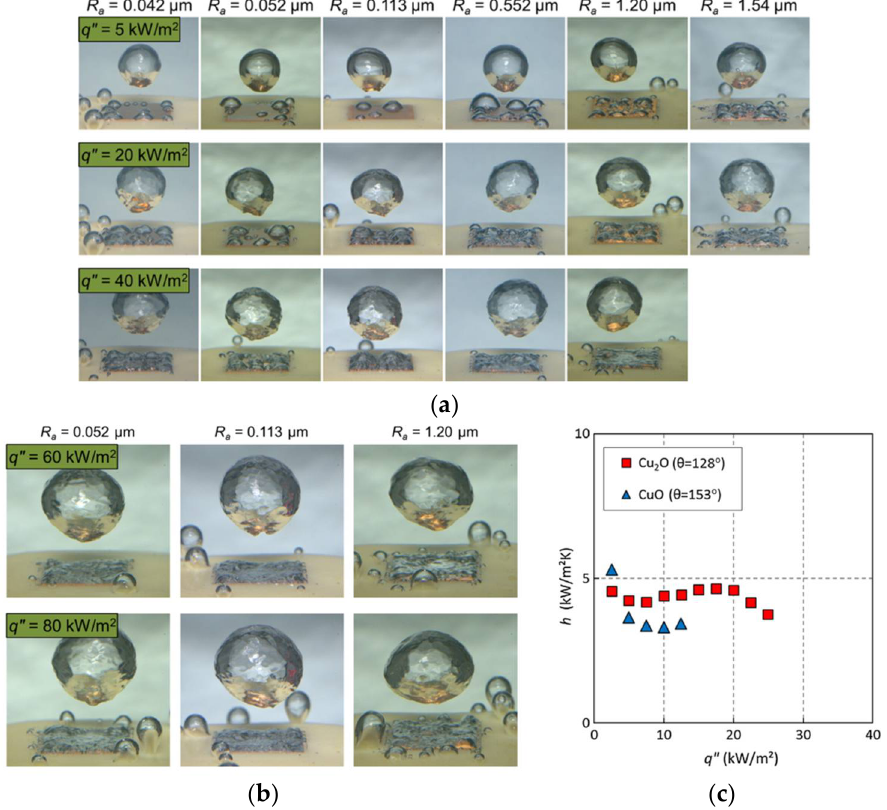
Figure 20. ( a ) Images of bubble nucleation and departure in nucleate and transition boiling regimes. ( b ) Images of bubble nucleation and departure in film boiling regime. ( c ) The change of heat transfer coefficient with the heat flux. Reprinted with permission from Ref [111]. Copyright 2018 Elsevier.